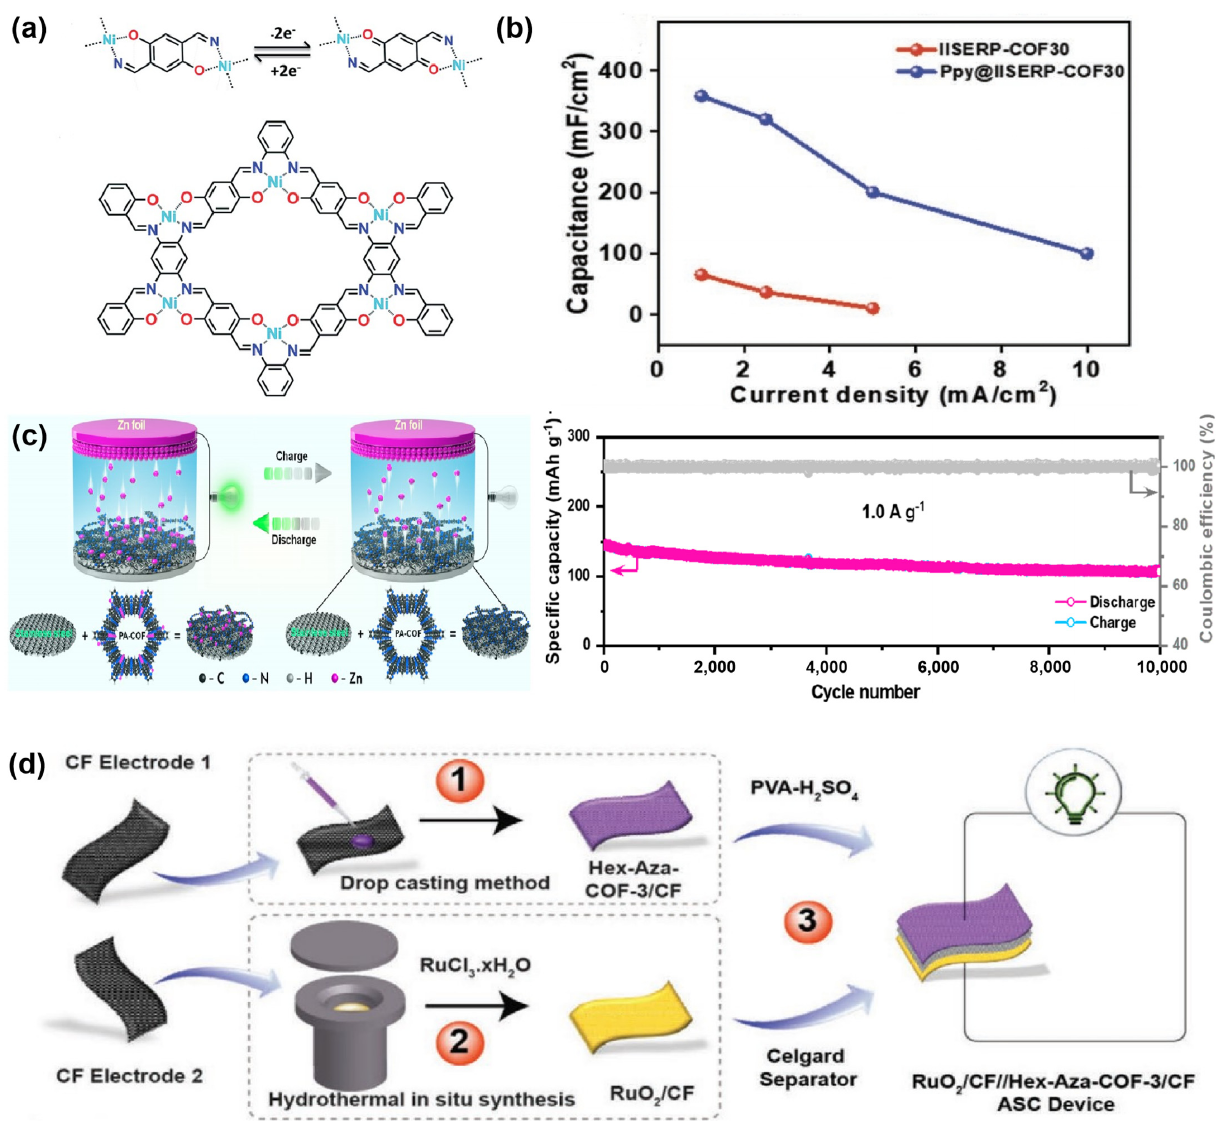
Figure 4. ( a ) The possible energy storage/conversion mechanism and π − conjugated structure of Ni − COF. Reprinted with permission from Ref. [51]. Copyright 2019, Royal Society of Chemistry. ( b ) Capacitance variation of COF and Ppy@COF at different current densities. Reprinted with permission from Ref. [52]. Copyright 2022, WILEY-VCH. ( c ) Schematic configuration of PA − COF||1.0 M ZnSO 4 ||Zn metal ZIS. Electrochemical behavior of PACOF in 1.0 M ZnSO 4 electrolyte within a potential window of 0.2 − 1.6 V. The remarkable cycling stability of PA − COF at a current density of 1.0 A g − 1 . Reprinted with permission from Ref. [53]. Copyright 2019, American Chemical Society. ( d ) Schematic representation illustrating the fabrication of RuO 2 //Hex − Aza − COF − 3 ASC device. Reprinted with permission from Ref. [54]. Copyright 2020, WILEY − VCH.